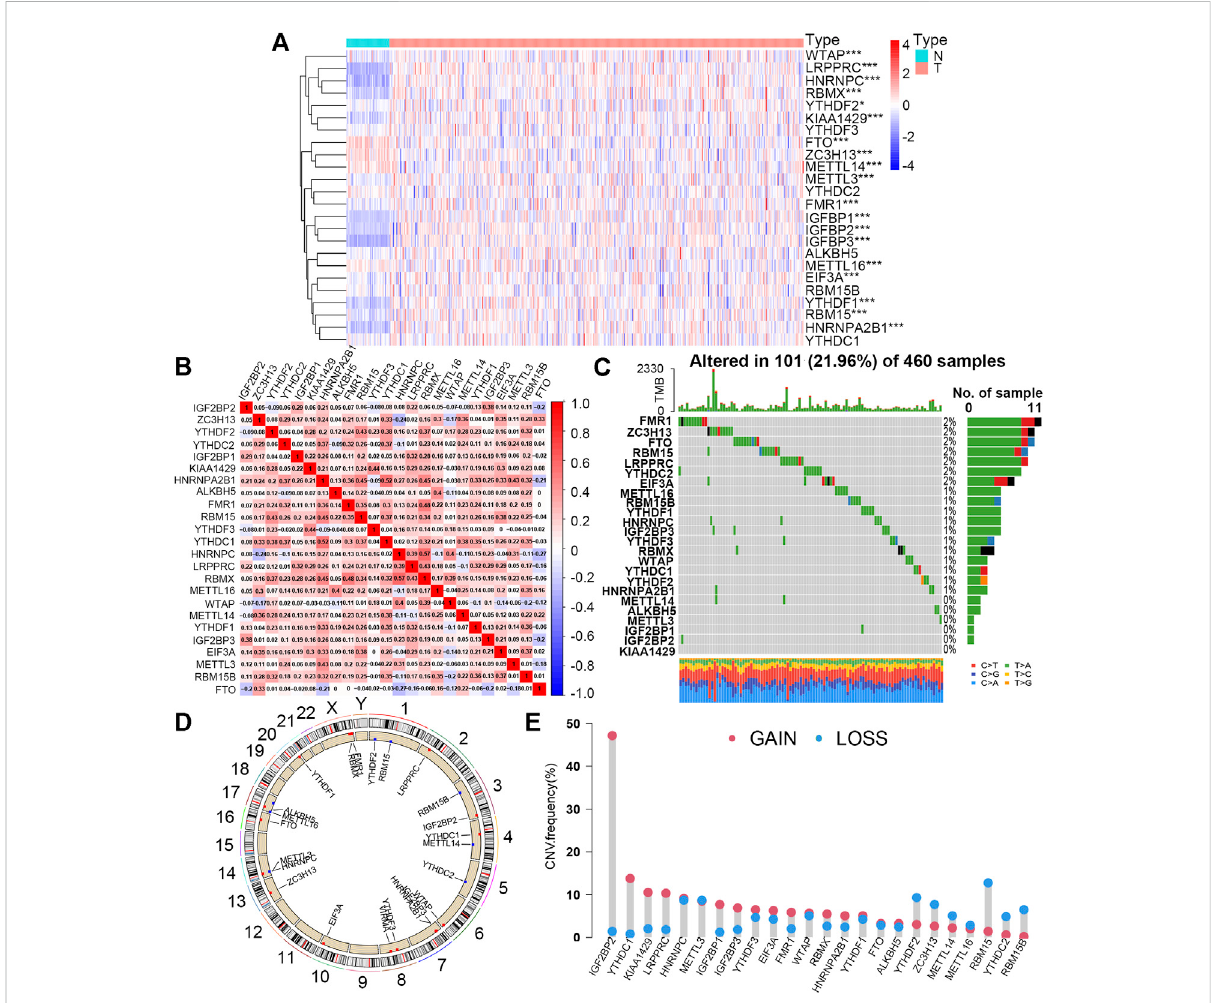
FIGURE 1 Expression levels and mutation features of 24 m6A regulators in the smoking-associated LUSC cohort from TCGA database. (A) Expression differences of 24 m6A regulators between normal (N) (n = 49) and tumor (T) (n = 473) samples (* p < 0.05; *** p < 0.001). (B) Expression correlation analysis of 24 m6A regulators in the smoking-associated LUSC cohort. Red and blue refer to positive and negative correlation, respectively. (C) Somaticmutationtypesandfrequencyof24m6Aregulatorsin460LUSCsampleswithsmokinghistory. (D) LocationsandCNVtypesof24m6A genes on 24 different chromosomes. Red and blue refer to the increased and decreased CNV types, respectively. (E) CNV frequency of 24 m6A regulators in the smoking-associated LUSC cohort. Red and blue refer to the increased and decreased CNV types,